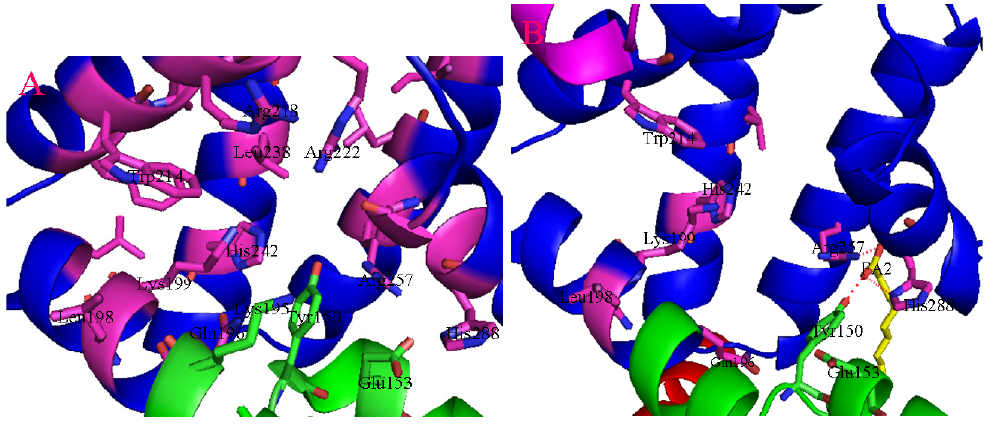
Figure 2. The binding environment of ligand site in IIA subdomain of HSA. ( A ) Site I; ( B ) Site I in HSA–FA. Domain IB, in green; domain IIA, in blue; Dashed line (red), hydrogen